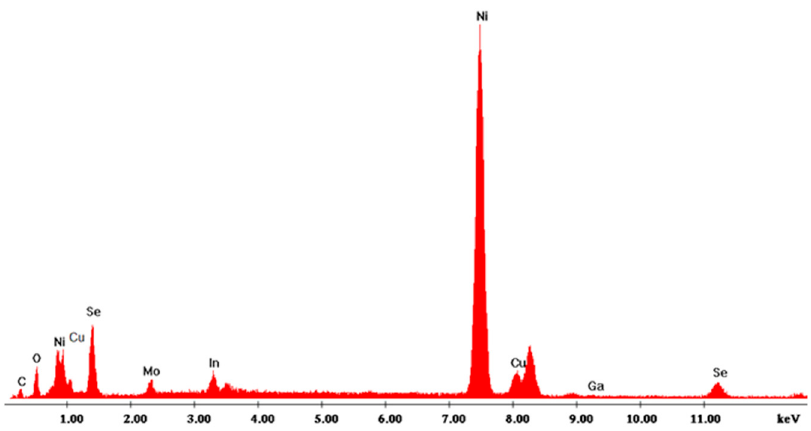
Figure 10. EDS spectrum of CIGS NWs. NWs were obtained at pH = 2.7 with a gallium content of 57 mM and at 1.53 mA/cm 2 .